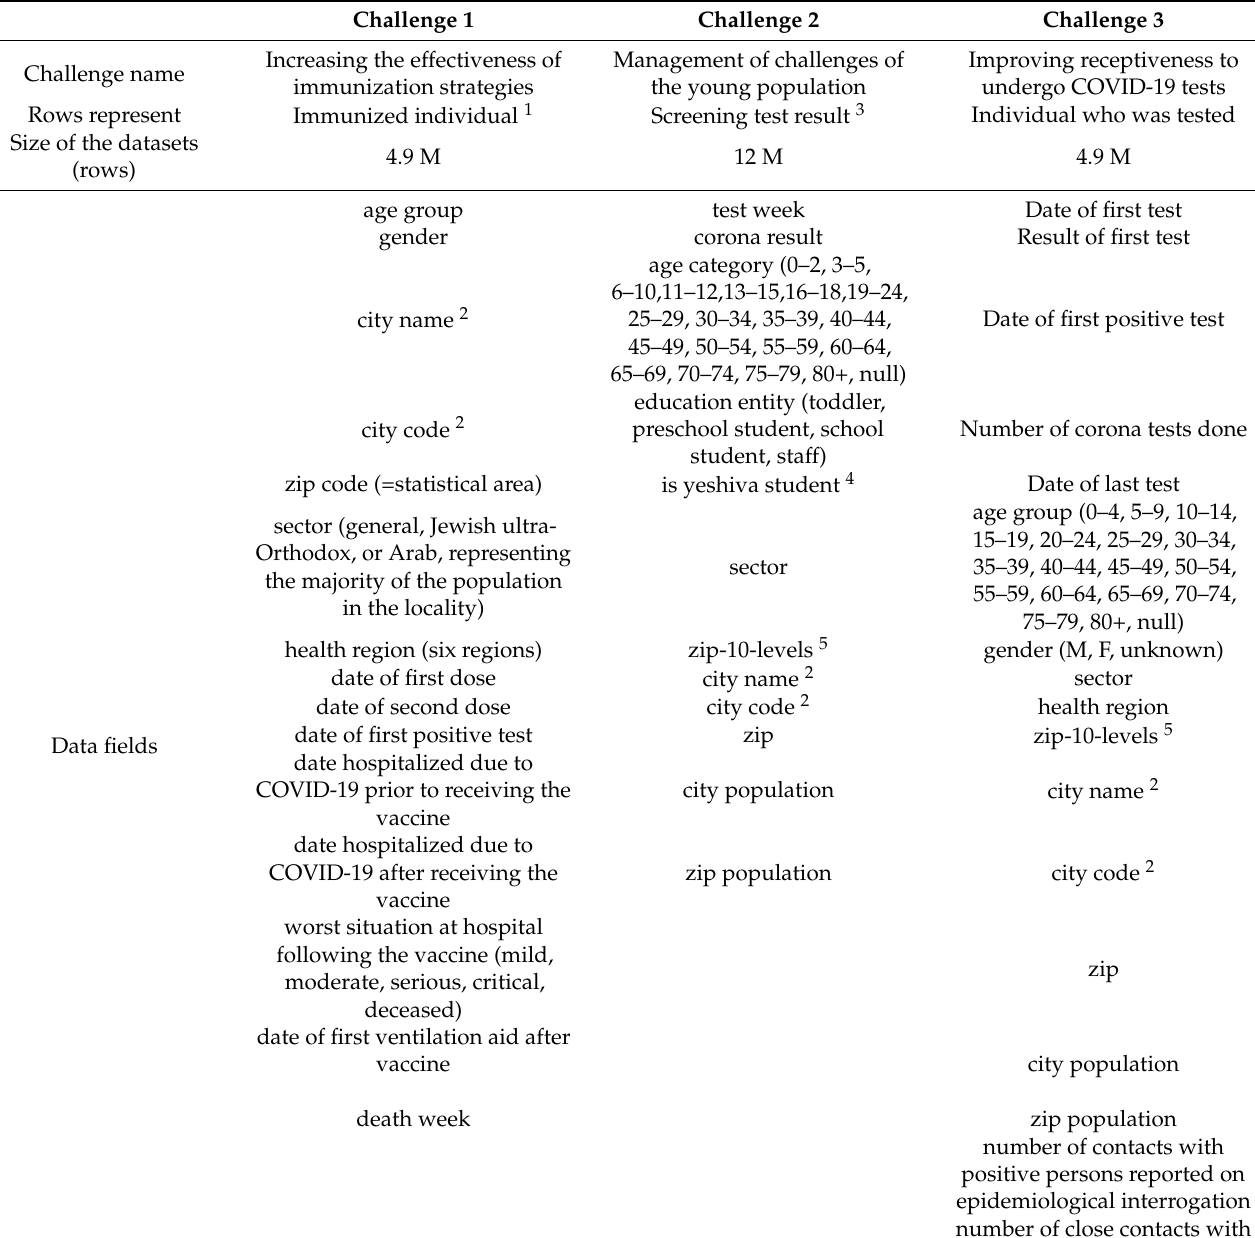
Table A1. Datasets for the Three